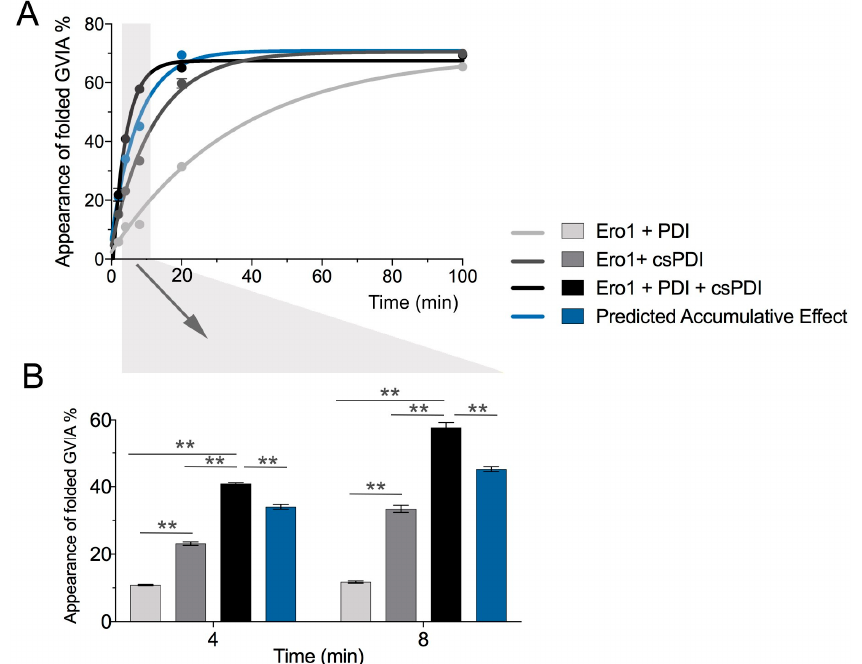
Figure 6. Synergistic effect of PDI and csPDI during Ero1-mediated folding of conotoxin ω -GVIA. ( A ) Folding assays were carried out in the presence of 10 µM PDI and/or 10 µM csPDI and 4 µM Ero1, quenched at different time points and analyzed by reversed-phase chromatography. The appearance of fully folded ω -GVIA was measured by taking the area under the curve of duplicate reactions (mean ± SD). ( B ) Plotted values represent folding yields obtained from early time points of folding (arrow and area shaded in gray in panel A). At 4 min and 8 min, PDI and csPDI exhibited a synergistic effect that was significantly higher than the predicted accumulative effect for both enzymes (shown in blue). Statistical analysis was performed using two-way ANOVA with time and treatment as independent variables using GraphPad Prism software (version 7). ** p < 0.01.